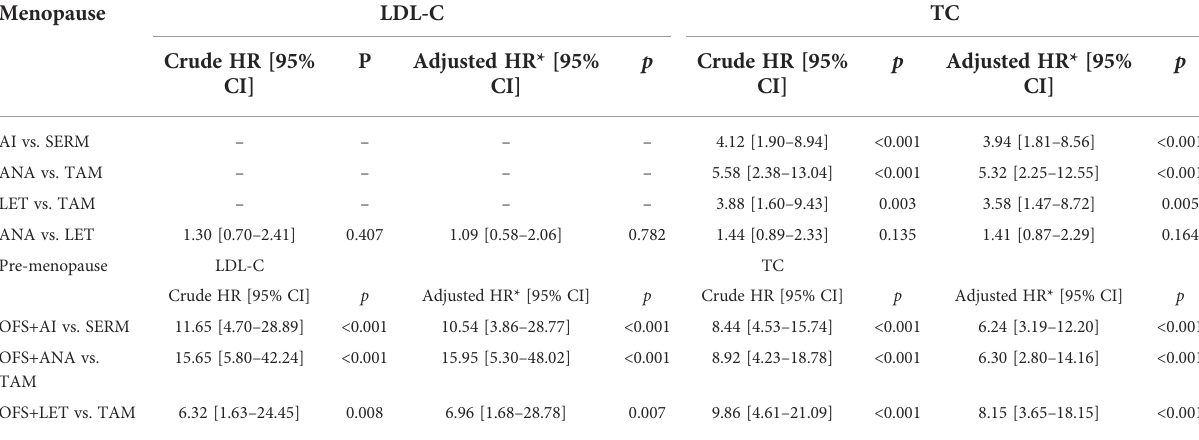
TABLE 2 Hazard ratio of LDL-C and TC dyslipidemia among early-stage breast cancer patients based on endocrine therapy used.